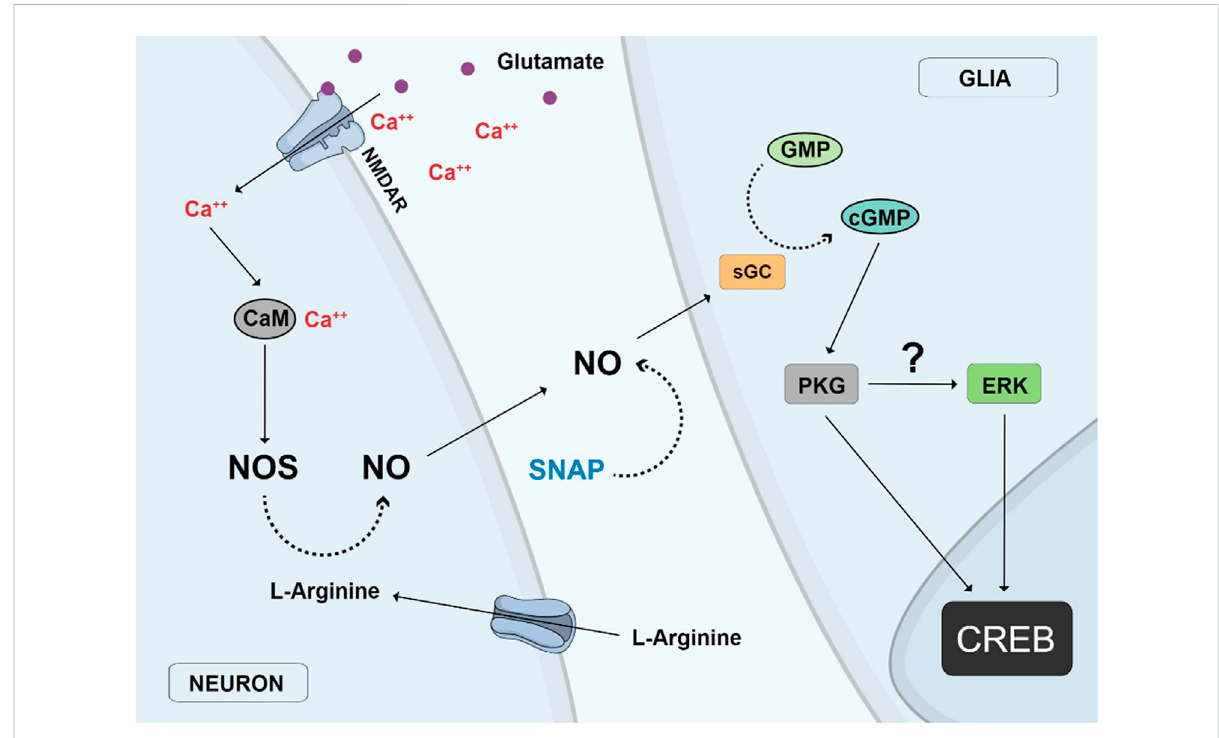
FIGURE 3 Nitric oxide (NO) neuronal-glial cycle. Activation of glutamate NMDA receptors (NMDAR) promotes calcium in fl ux and stimulation of the calcium/calmodulin enzyme nitric oxide synthase (NOS) and NO production in neurons. NO diffuses out from neurons to glial cells where it stimulatessolubleguanylylcyclase(sGC)toproducecyclicGMPwhichactivatesproteinkinaseG(PKG),whichthenstimulatesErkand fi nallyCREBin glial cell nuclei. The same effect is observed with the addition of the NO donor SNAP or the uptake of L-arginine, the substrate of